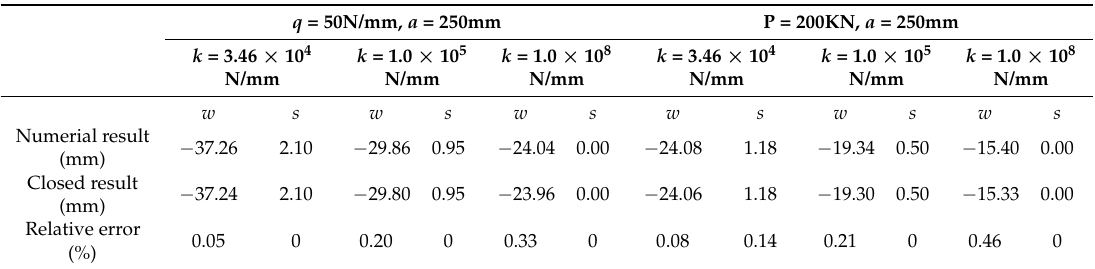
Figure 5. Details of the simply supported composite beam. (a) uniformly distributed load; (b) point load; and (c) cross-sectional properties Table 1. Comparison of maximum deflection and the interface slip of the beam end for two types of load.